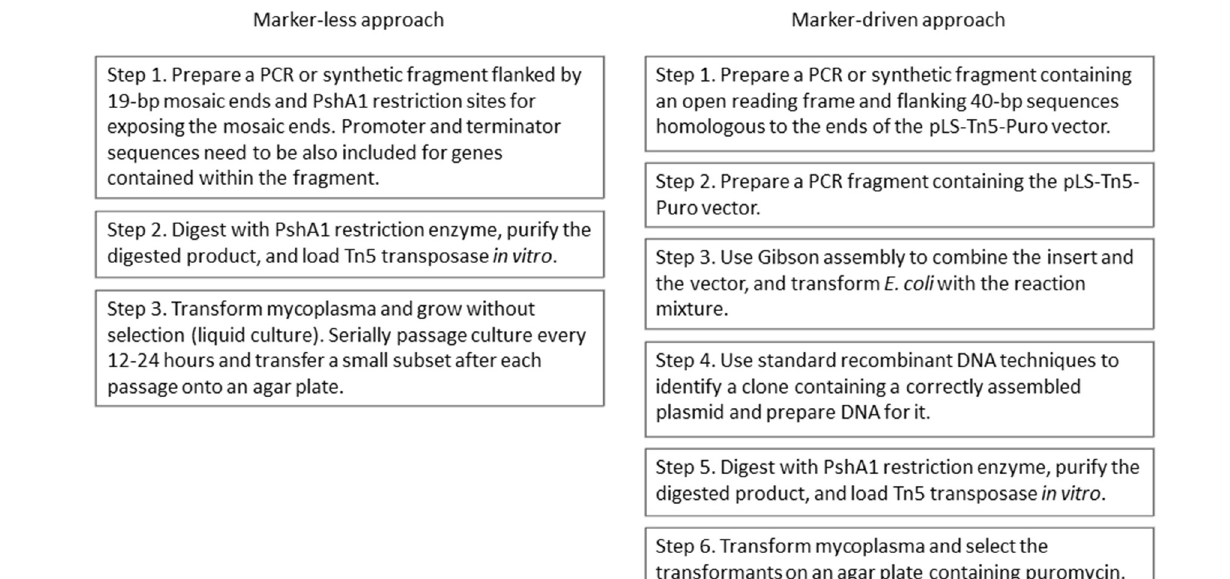
Frontiers in Microbiology | Systems